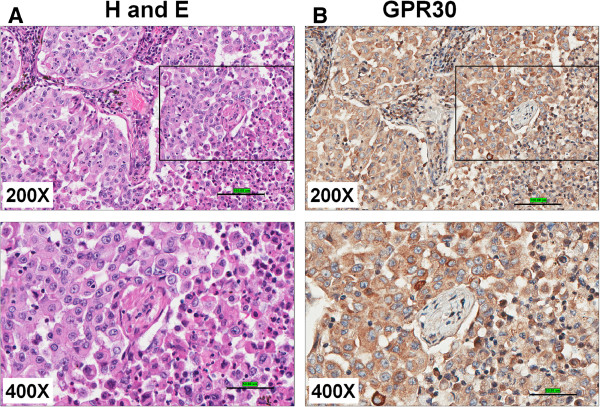
GPER/GPR30 expression in human large cell lung carcinoma. The TMA stained with H&E and anti-GPR30. The representative tissue images of stained with H and E (A) and anti-GPR30 (B) of large cell carcinoma are shown at 200X and 400X magnifications. The scale bar for 200X is 100 μm and 400X is 50 μm. The images were collected using Aperio imagescope.